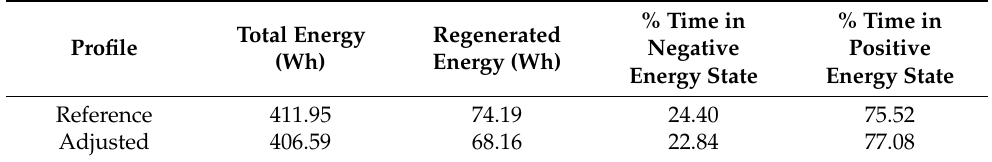
Table 14. Energy-related summary statistics under reference and adjusted speed profiles for the Lisbon case with reversed road